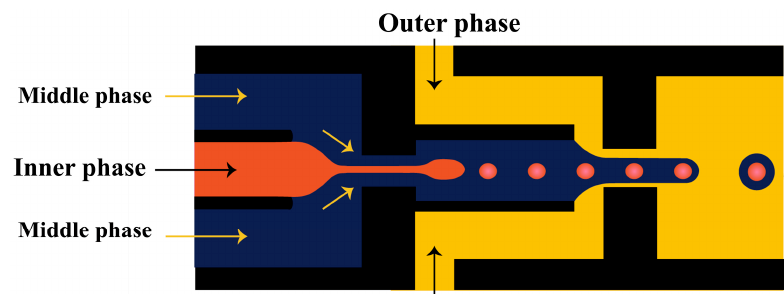
Figure 5. Two consecutive flow-focusing drop generators with different wettability for producing core/shell drops. The upstream and downstream orifice was wetted with the middle and outer fluid, respectively [111].